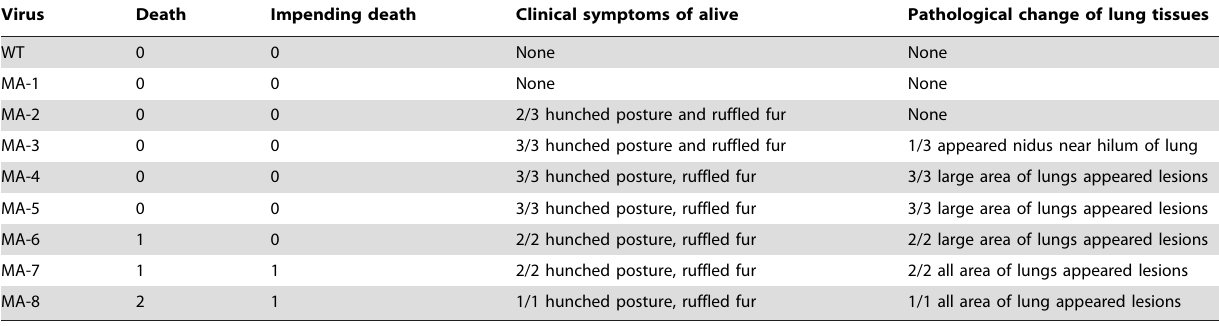
Table 1. Clinical characteristics of mice.